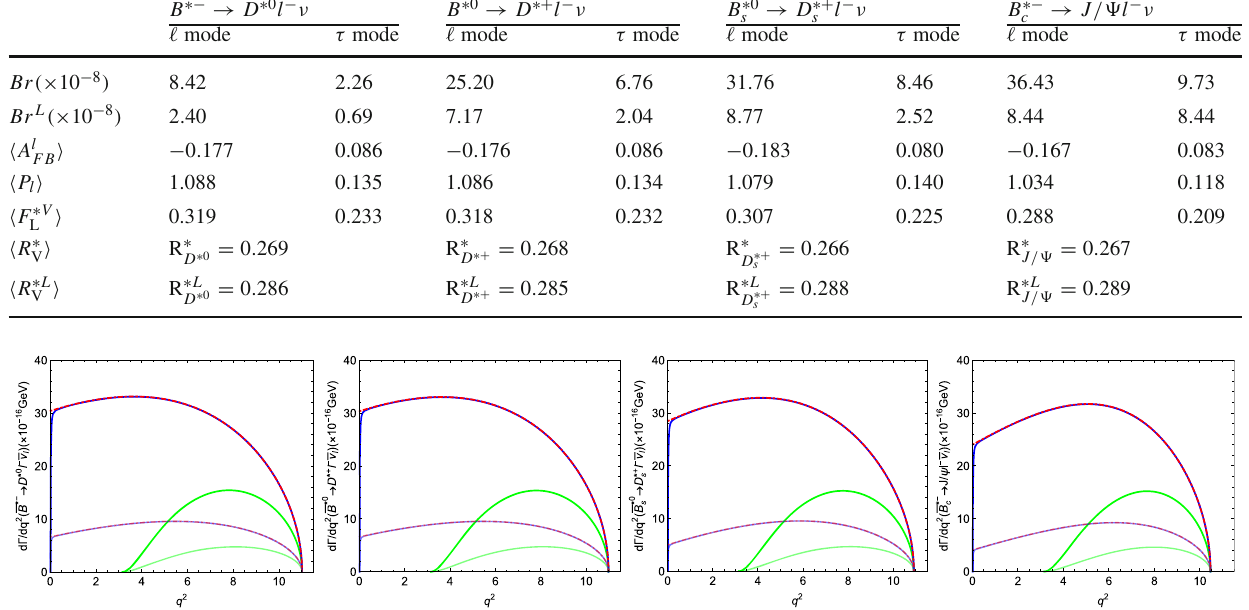
Table 4 The SM central values prediction for branching fractions Br , the lepton polarization fraction (cid:9) P l (cid:10) , the hadron polarization fraction (cid:9) F ∗ V (cid:10) ,theforward-backwardasymmetry (cid:9) A l L